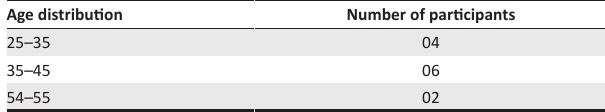
TABLE 3: Age distribution of